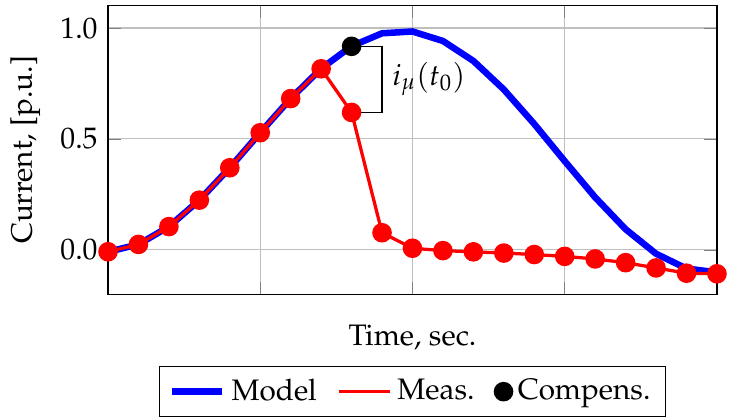
Figure 3. The process of i µ calculating at the saturation moment t 0